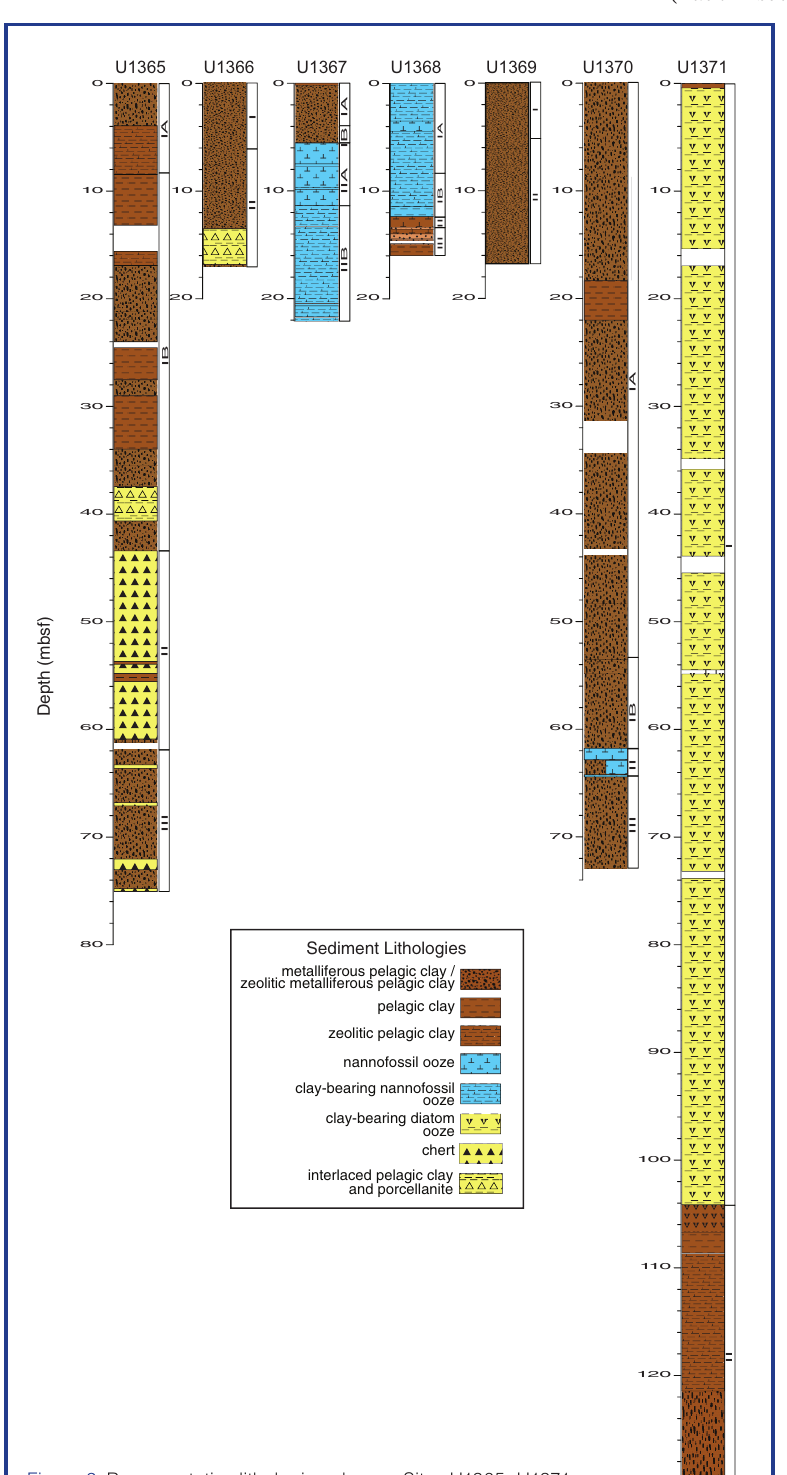
Figure 2. Representative lithologic columns, Sites